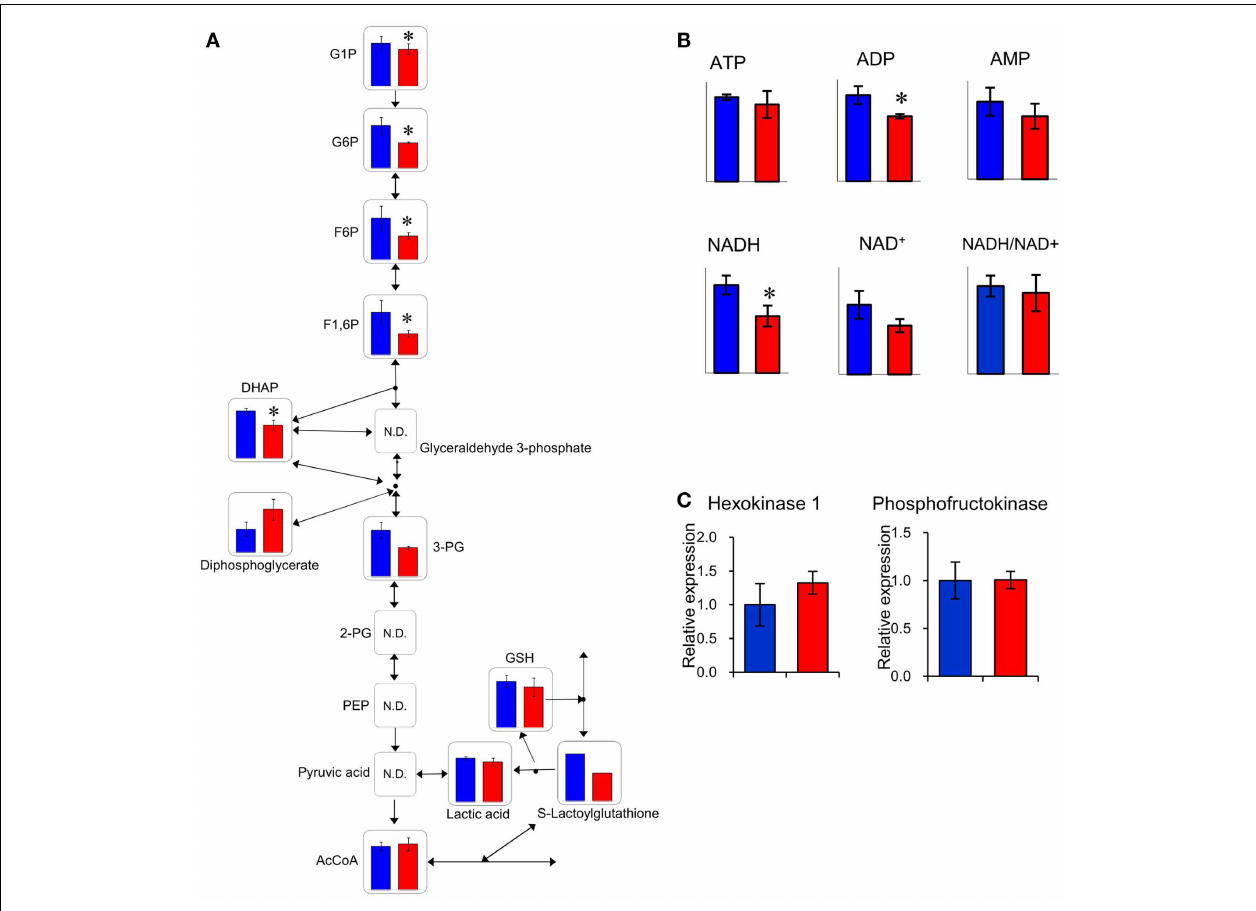
FIGURE 3 | Comparison of glycolytic metabolic activity between GF mice and Ex-GF mice . (A) The relative quantities of the annotated metabolites are represented as bar graphs (blue, GF: red, Ex-GF). (B) Relative quantities of ATP, ADP, AMP, and nicotinamides (* p < 0.05). (C) Cerebral gene expression of hexokinase and phosphofructokinase. Data are represented as mean ± SD (A,B) and mean ± SEM (C)